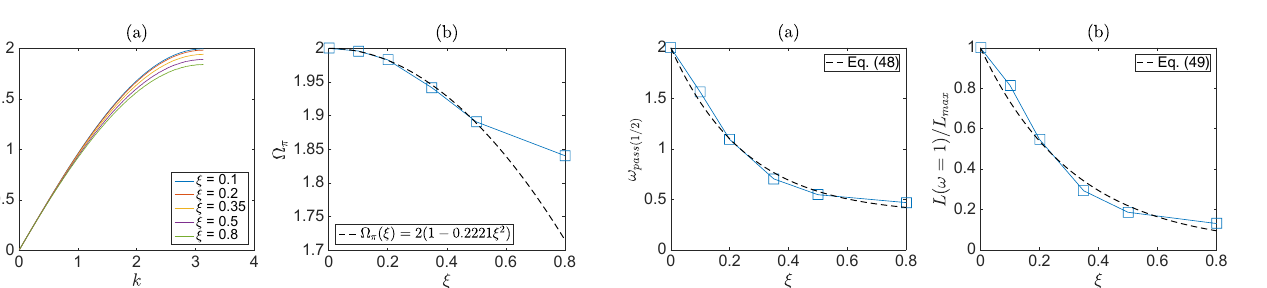
Figure 12. (a) ω pass ( 1 / 2 ) and (b) localization length at ω = 1 scaled with maximum localization length ( L max ) for different ξ